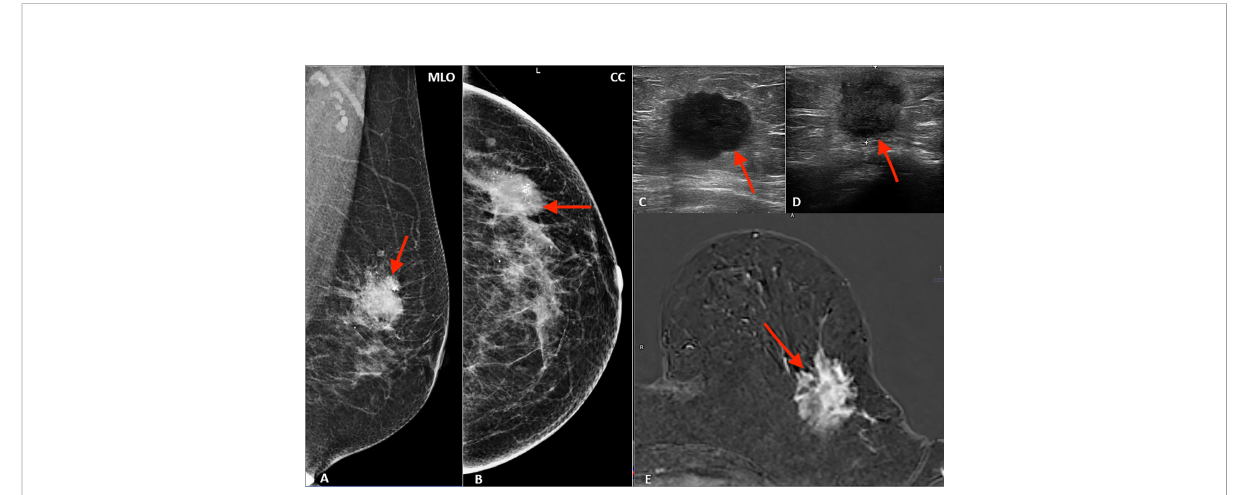
FIGURE 1 Multimodality presentation of lobular breast cancer; Patient 1 left breast: (A, B) mammography: MLO (A) and CC (B) — not circumscribed, spiculated mass with microcalci fi cations (red arrow); (C, D) ultrasound — not circumscribed, spiculated, hypoechoic mass (red arrow); (E) MRI T1 post contrast — not circumscribed, spiculated mass with heterogenous contrast enhancement (red